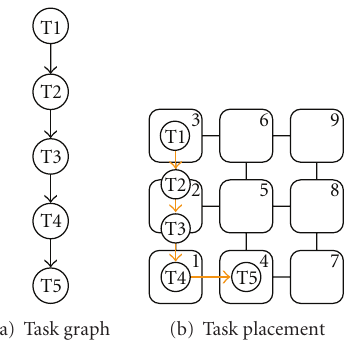
Figure 1: A task graph and its placement on an NPU array.